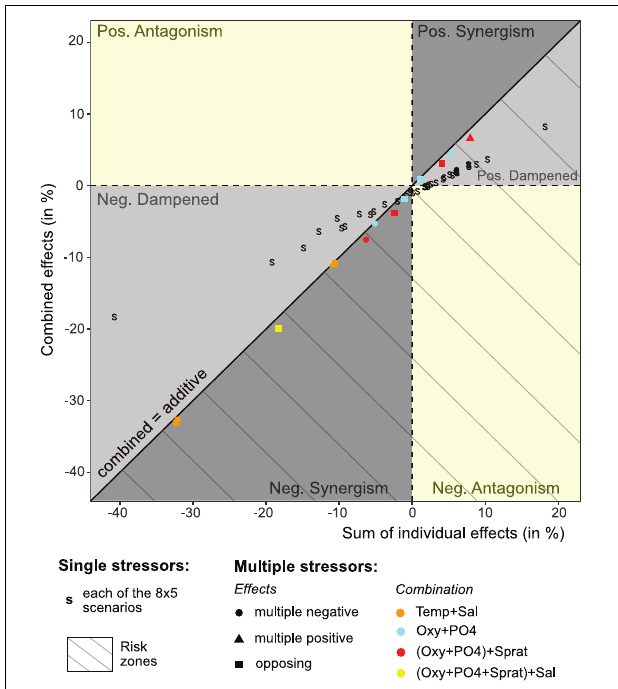
FIGURE 4 | Comparison of the combined versus additive individual stressor effects. The combined effects were simulated for 13 scenarios in which we combined increasing or decreasing trends in two or more stressors that had the same positive, negative or opposing effects on Pseudocalanus acuspes abundances. Effects are presented as percent change of mean seasonal abundances over the course of 10 years, averaged across 1000 Monte Carlo simulations. The additive effects are calculated as the sum of mean percent change under single environmental changes (shown in Figure 3 ). For single stressor simulations the combined effect represents the net effect on the total population in comparison to the sum of individual seasonal stage effects. Population responses to single changes in salinity by 25 and 50% are not shown as they lied outside the selected X- and Y-range. The gray and yellow areas indicate the type of interaction present, i.e., positive and negative synergism, antagonism and dampening effects. All interactions below the diagonal lines are considered as risk zones where combined effects lead to lower abundances than expected under additive